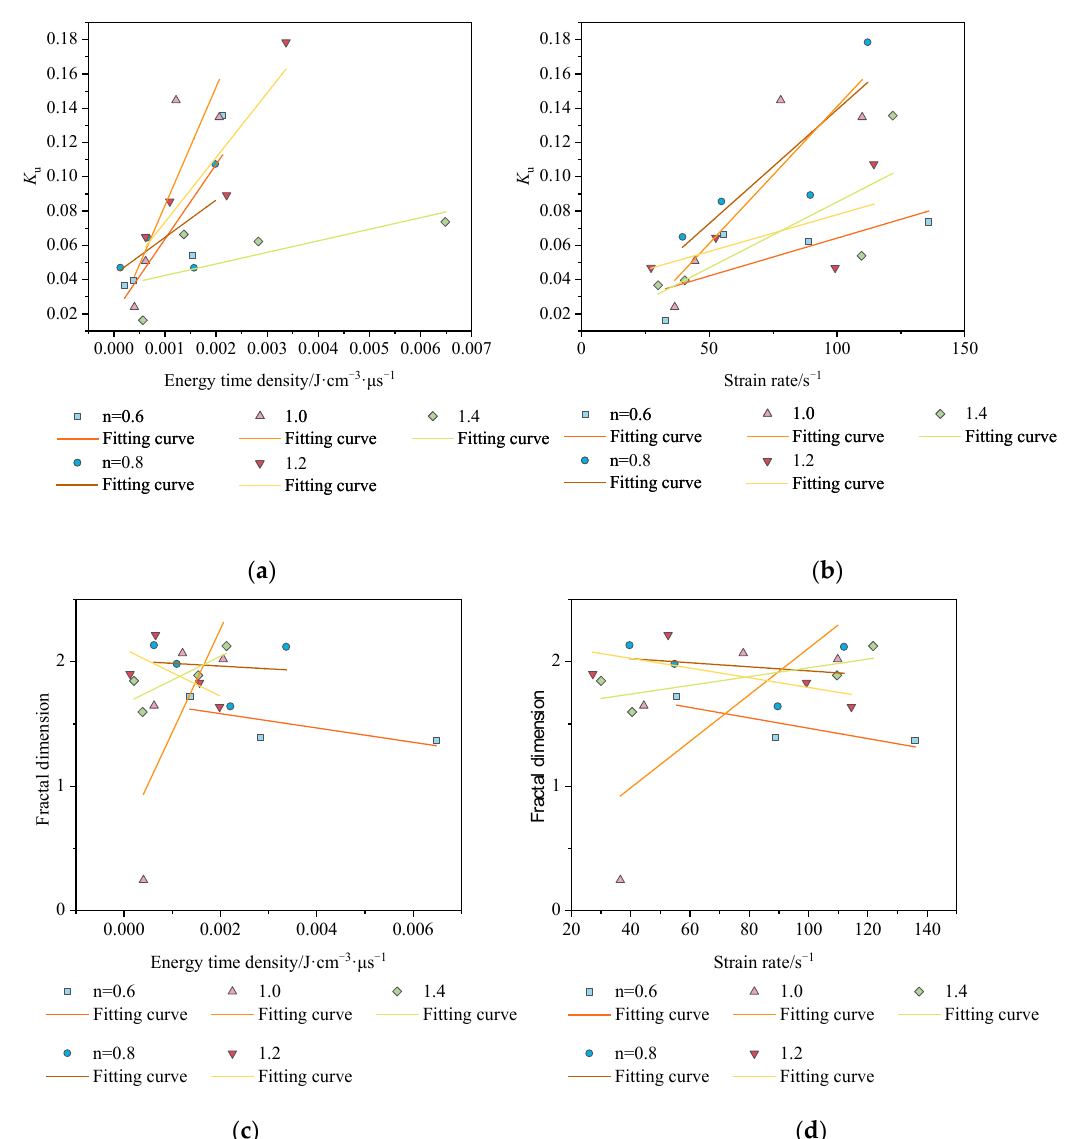
Figure 10. Plots of the relationship between the strain rate and degree of fragmentation: ( a ) the peak energy time density— K u curve; ( b ) the strain rate— K u curve; ( c ) the energy time density— D ( d ) the strain rate— D .